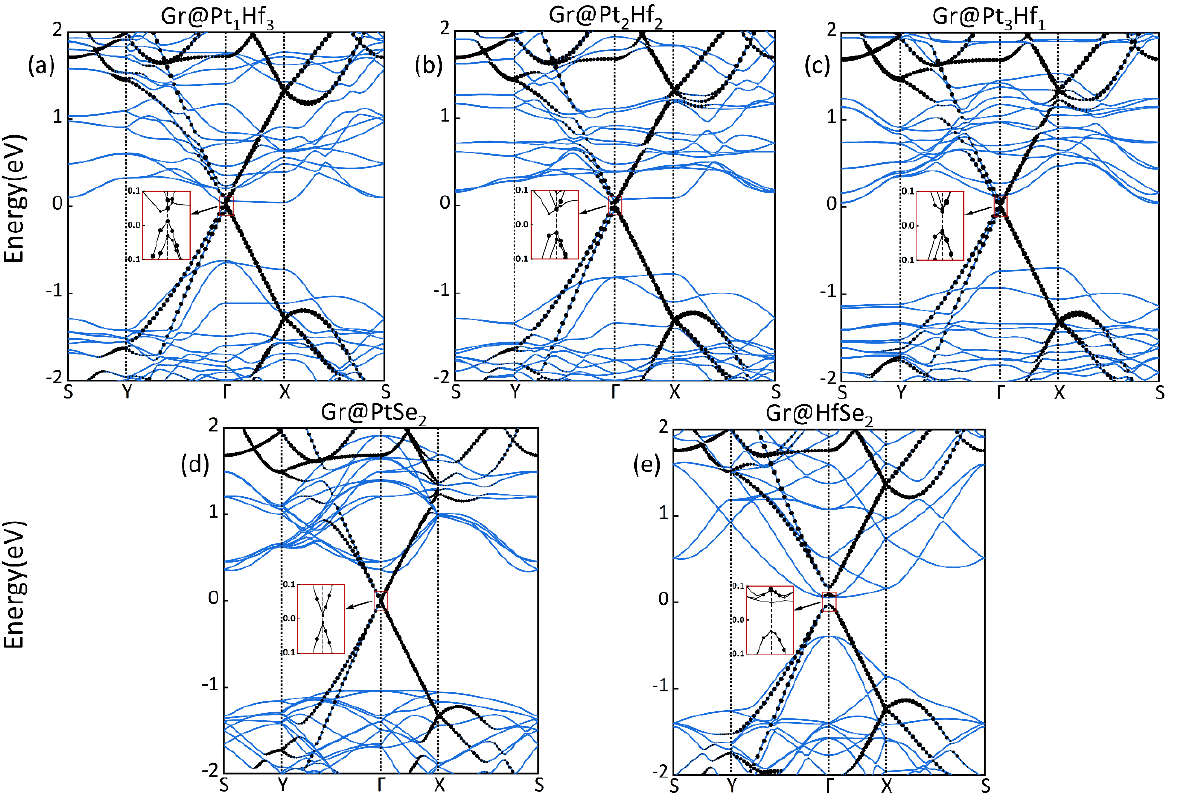
Figure 4. Calculated DOS and PDOS for ( a ) Pt 1 Hf 3 , ( b ) Pt 2 Hf 2 , ( c ) Pt 3 Hf 1 , ( d ) Graphene, ( e ) PtSe 2 , and ( f ) HfSe 2 , where an energy level of zero is scaled to the Fermi level.